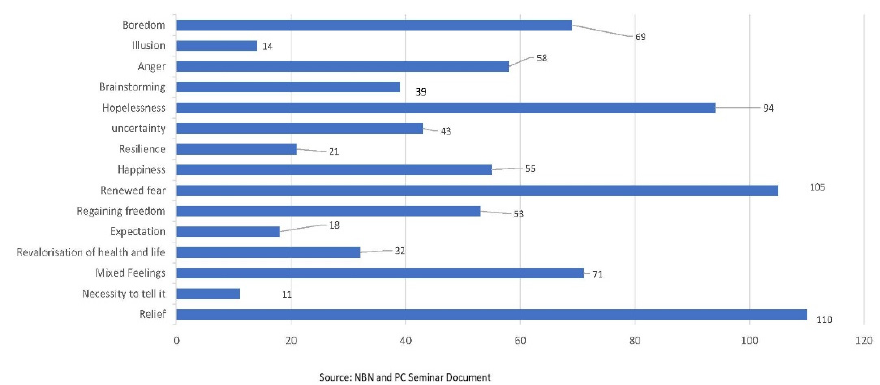
Figure 3. Feelings on the last confinement day.